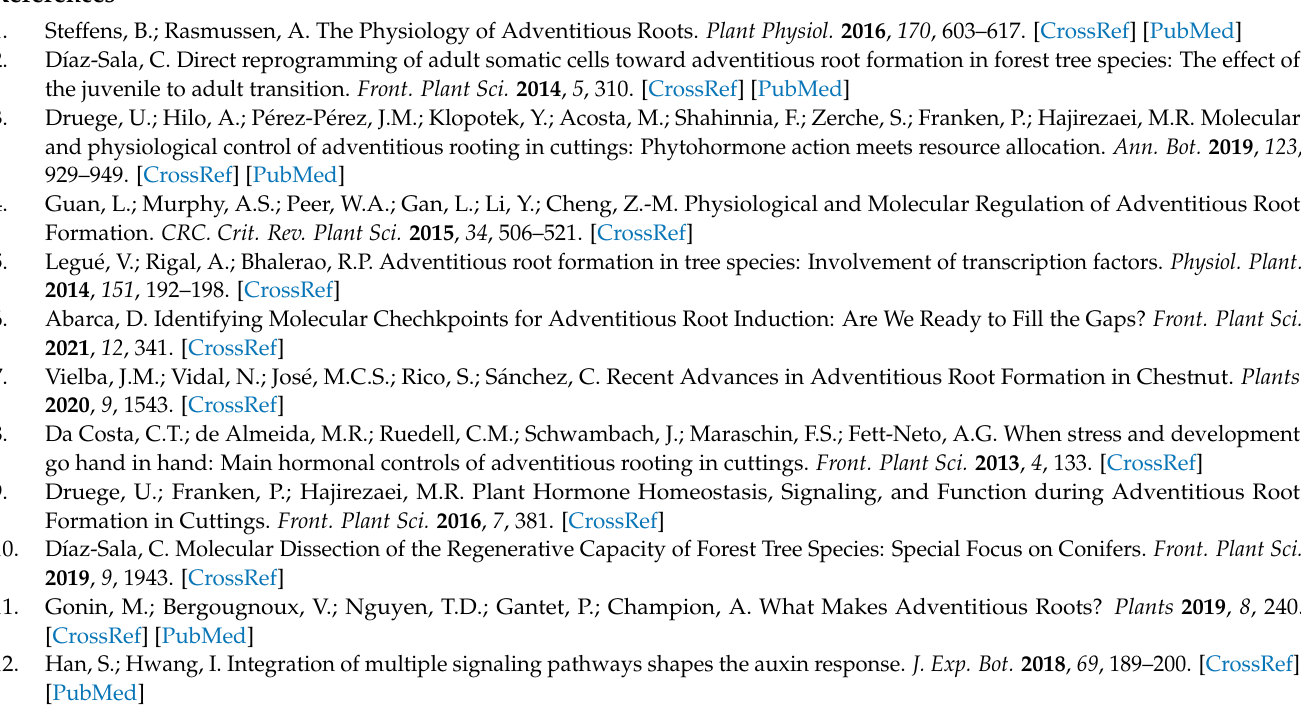
Figure S2: Treemaps of the BLAST2GO Ontology analysis of the BS_DE library; Figure S3: Treemaps of the BLAST2GO Ontology analysis of the CR_DE library; Figure S4: qPCR validation; Table S1: list of DEGs in the BS_DE library; Table S2: list of DEGs in the CR_DE library; Table S3: number of Uncharacterized genes, Pseudogenes and long non-coding RNAs (lncRNAs) in the BS_DE and CR_DE libraries; Table S4: transcription factors detected in the BS_DE library; Table S5: transcription factors detected in the CR_DE library; Table S6: list of genes related to Plant Hormone Signaling Pathways in the BS samples; Table S7: list of genes related to Plant Hormone Signaling Pathways in the CR samples; Table S8: primers used for qPCR analysis of the expression of the MADS-box genes and the qPCR